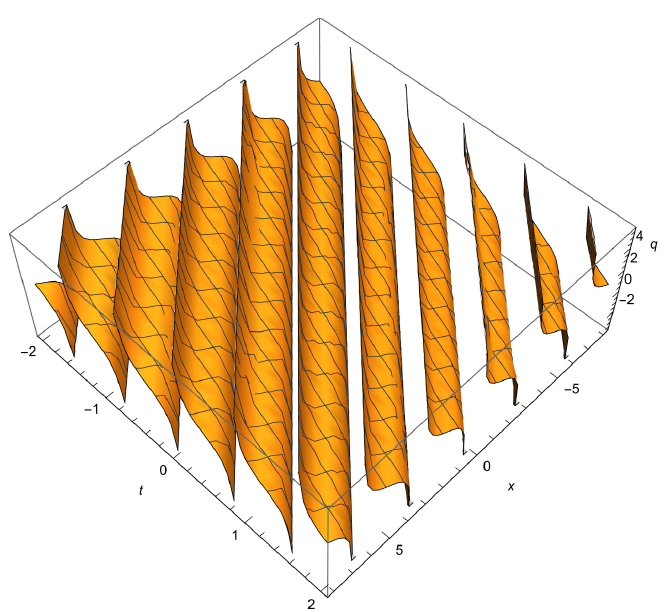
Figure 3. Graph of solution (32) taking the plus